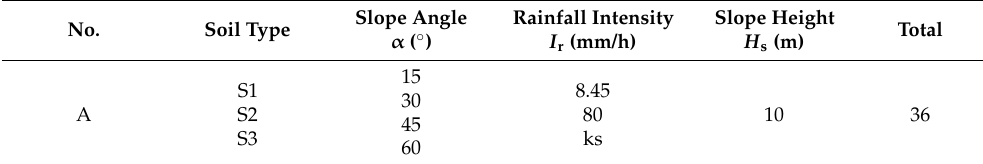
Table 4. Parameter design of influencing factors of slope stability under constant rainfall.